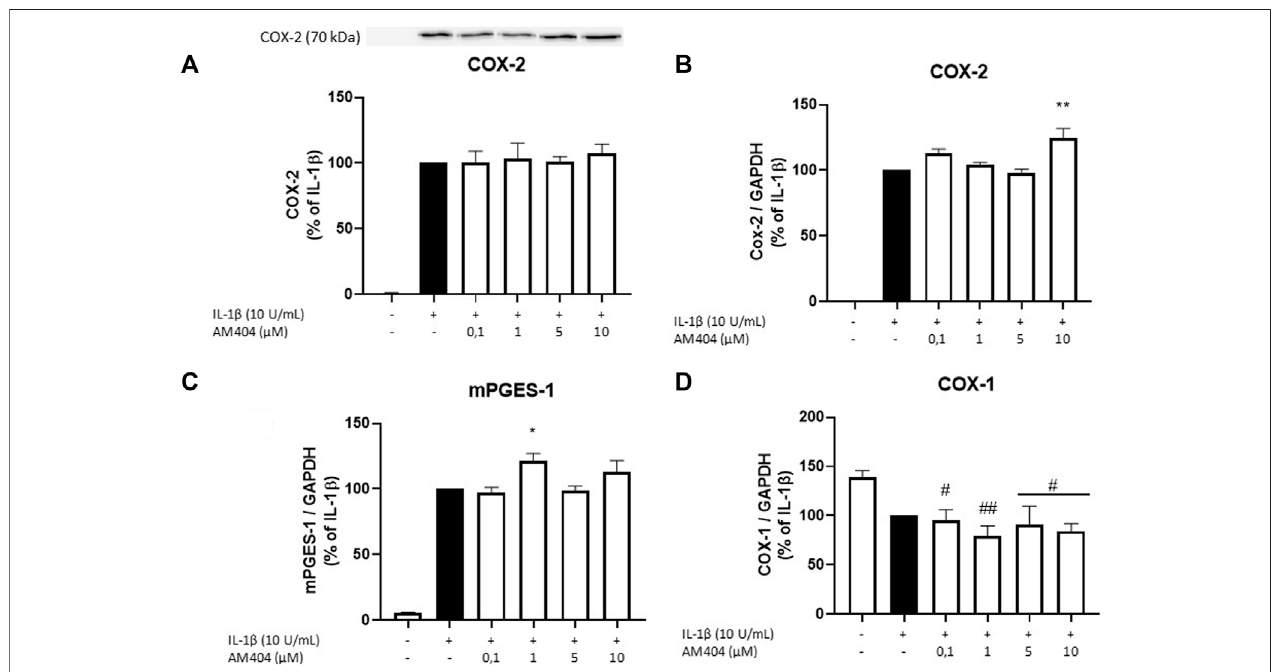
FIGURE2 | Effects ofAM404on COX-2 protein levels (A) , COX-2 expression (B) , mPGES-1 expression (C) , and COX-1 expression (D) in IL-1 β -stimulated SK-N- SH-cells. Cells were stimulated as described under material and methods. After 4 h of stimulation, RNA was isolated and mRNA levels of the shown target genes were measured in qPCR. Values are presented asthe mean ± SEM ofat least three independentexperiments. Statistical analysiswas performed using one-way ANOVA with Dunnett ’ s post hoc tests with */# p < 0.05, **/## p < 0.01 compared to IL-1 β (A – C) or to untreated cells (D) .